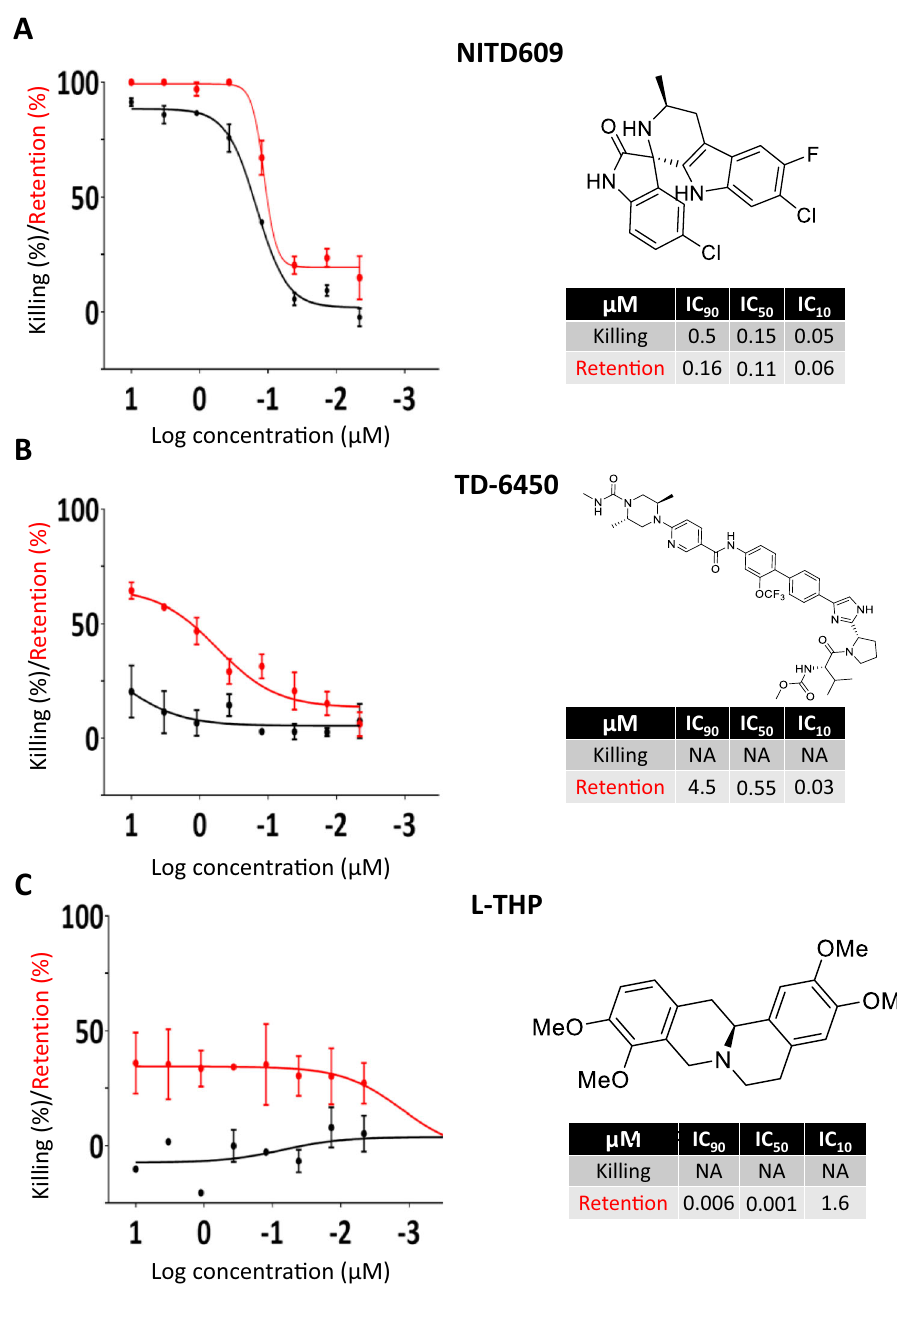
Fig.3|Dose-responsecurvesofselectedhits. Dose-responsecurvesandchemical structuresofthe3selectedhits:NITD609( A ),TD-6450( B )andL-THP( C ).TD-6450 was a pure enantiomer. Stereocenters are: (S) − 1-((S) − 2-(5-(4 ’ -(6-((2R,5S). Data are